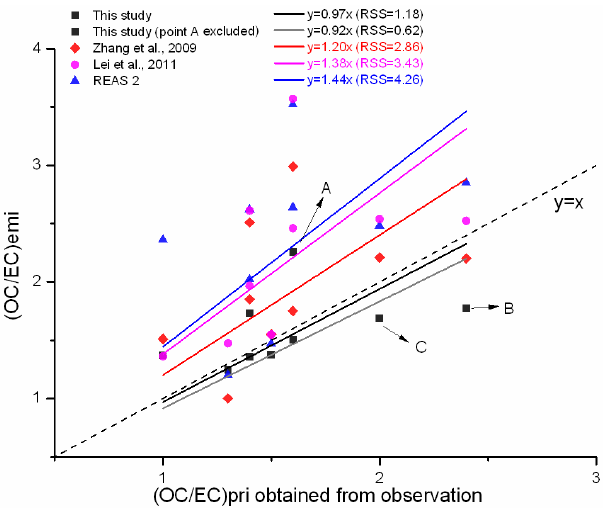
Figure 9. Correlation of (OC / EC) pri from ground observation (X. Zhang et al., 2008) and (OC / EC) emi from provincial emissions es- timated by different inventory studies. Points A, B, and C represent the observations at Nanning, Longfengshan, and Jinsha, and emis- sion results for corresponding provinces (Guangxi, Heilongjiang, and Hubei),